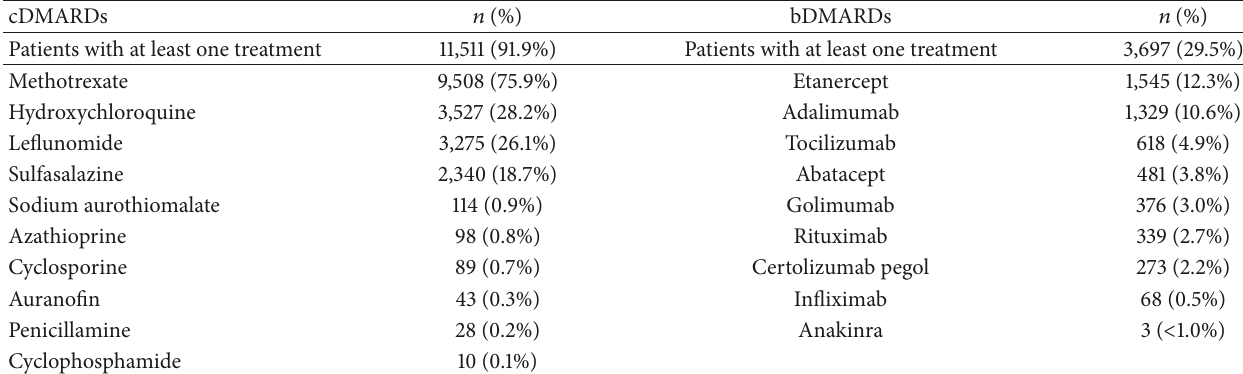
Table 2: Distribution of treatments in the total patient cohort ( 𝑁 = 12,526). Multiple occurrences of the same medication in one individual were counted once.